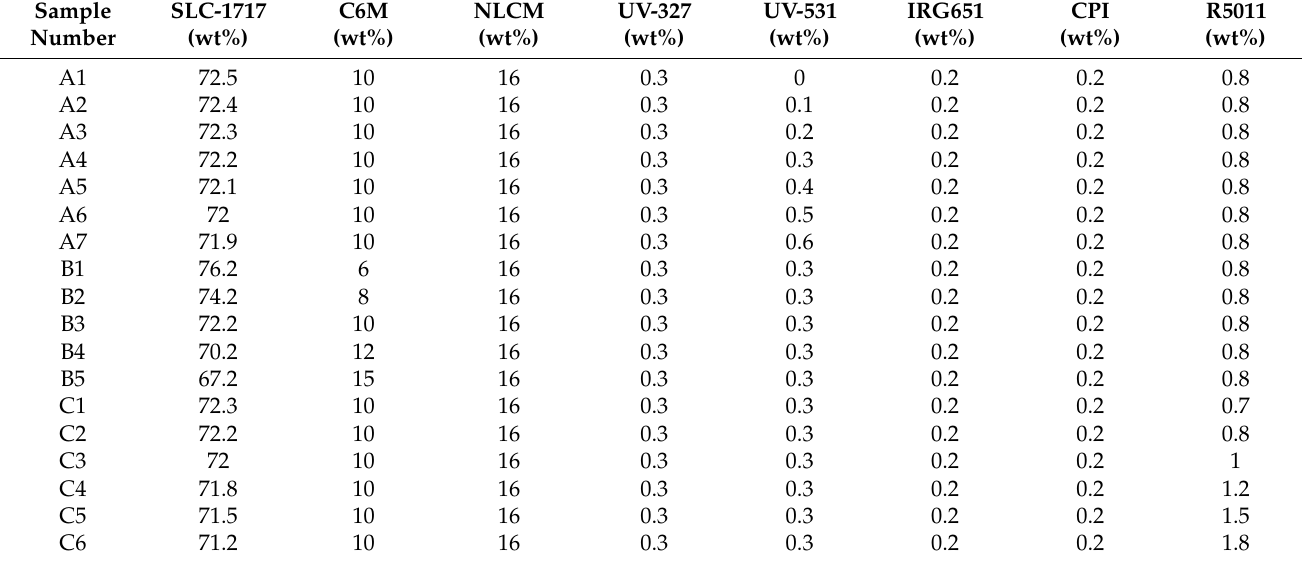
Table 1. Compositions of the samples studied.